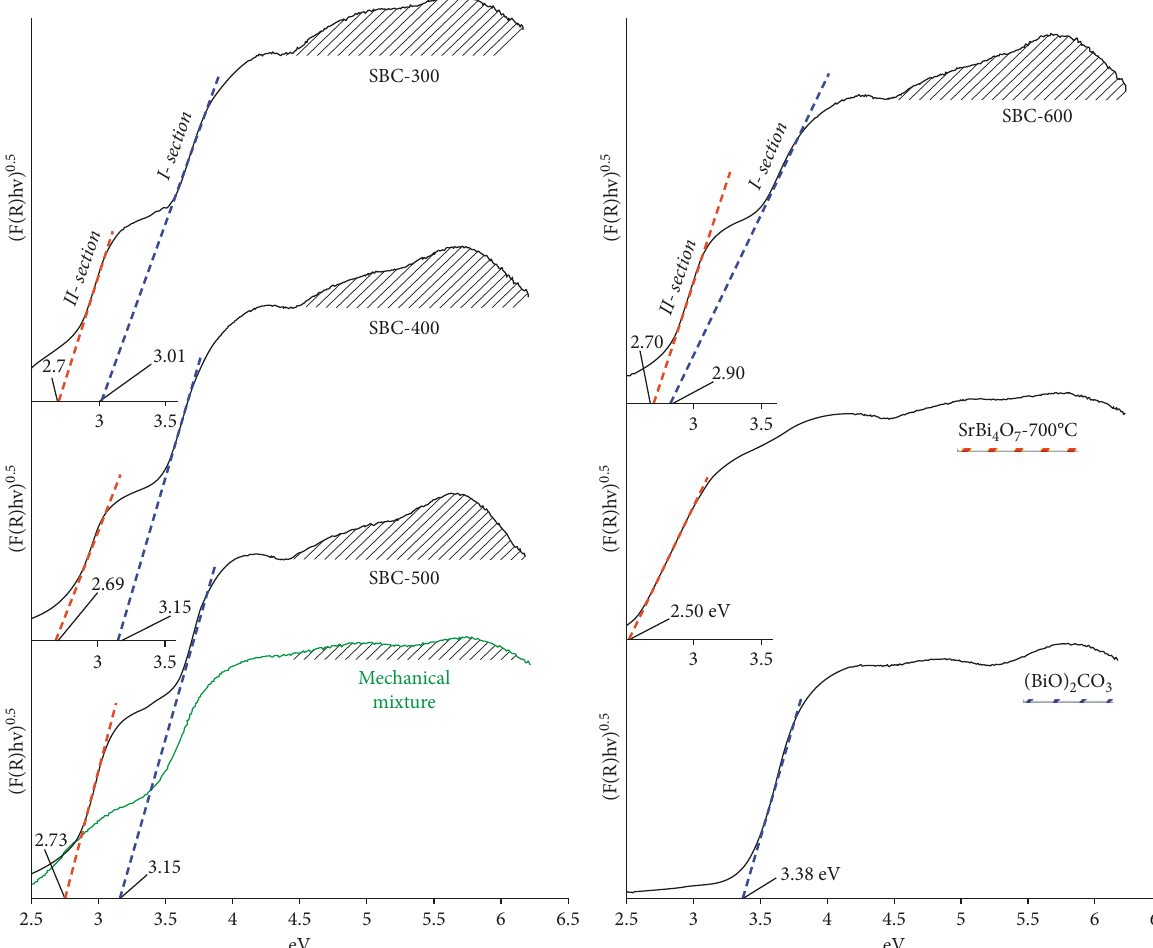
Figure 3: Dependences ( F ( R ) h ] ) ½ of single-phase samples of SrBi 4 O 7 and (BiO) 2 CO 3 and the compositions SBC-300, SBC-400, SBC-500, and SBC-600 and their mechanical mixture of 73% SrBi 4 O 7 +27% (BiO) 2 CO 3 from photon